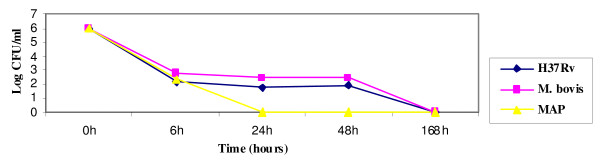
Growth index of M. tuberculosis H37Rv, M. bovis and M. paratuberculosis in enteric glial cells.